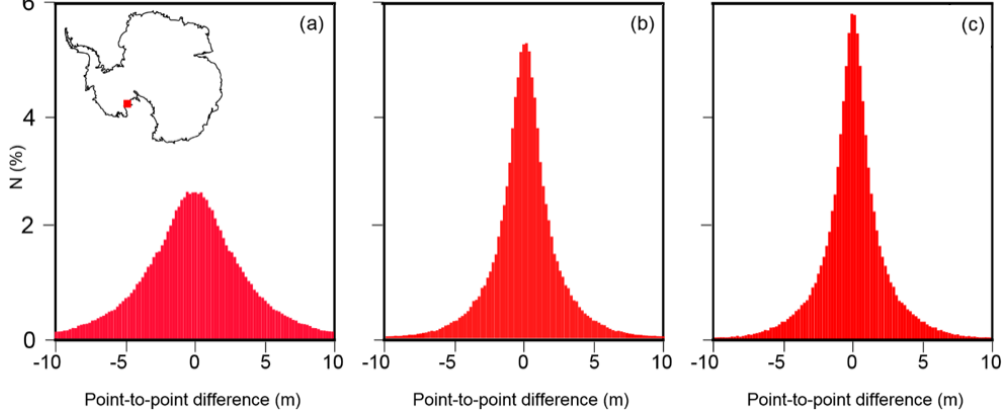
Figure 6. Point-to-point comparison of swath data over the Siple Dome (red box in map insert) for (a) Baseline-C with original star tracker measurements (b) Baseline-C with revised star tracker measurements and (c)